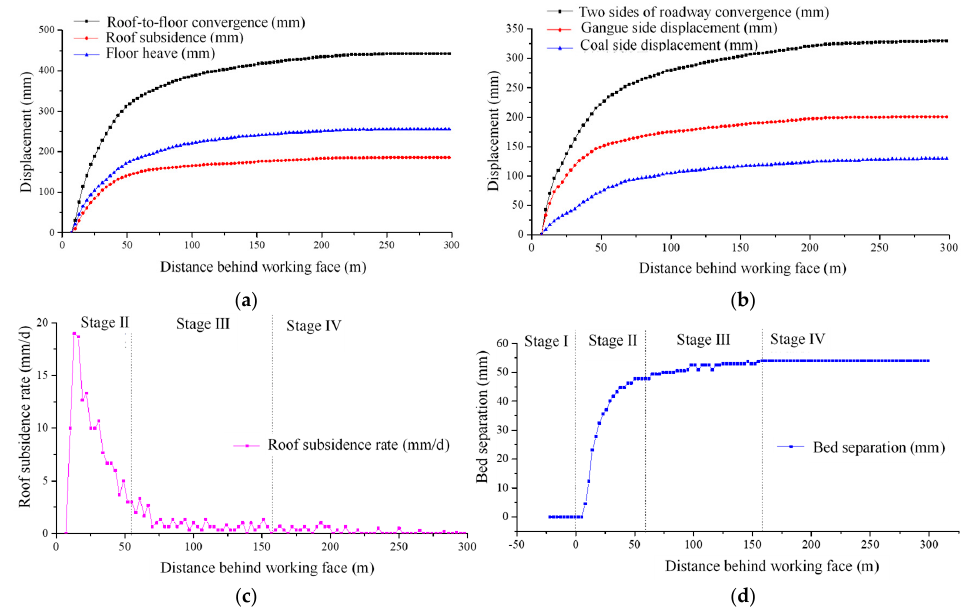
Figure 20. Deformation of entry surrounding rock using GERRC. ( a ) displacement of the entry roof and floor behind the working face; ( b ) displacement of two sides of the entry behind the working